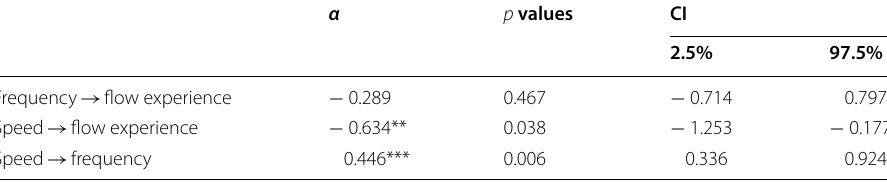
β regression coefficient, CI confidence interval, Frequency frequency of students’ action, Speed speed of students’ action ** p < 0.05 , *** p <